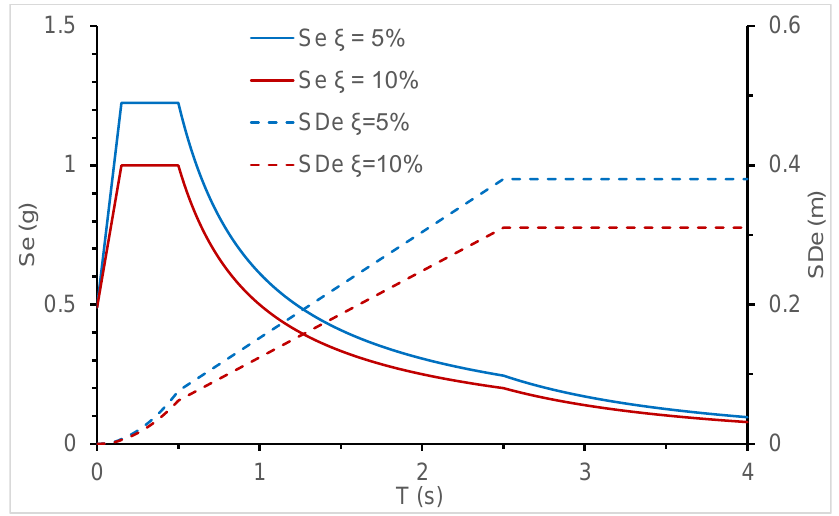
Figure 4. Acceleration spectra (continuous line) and displacement spectra (dotted line) at the ULS.